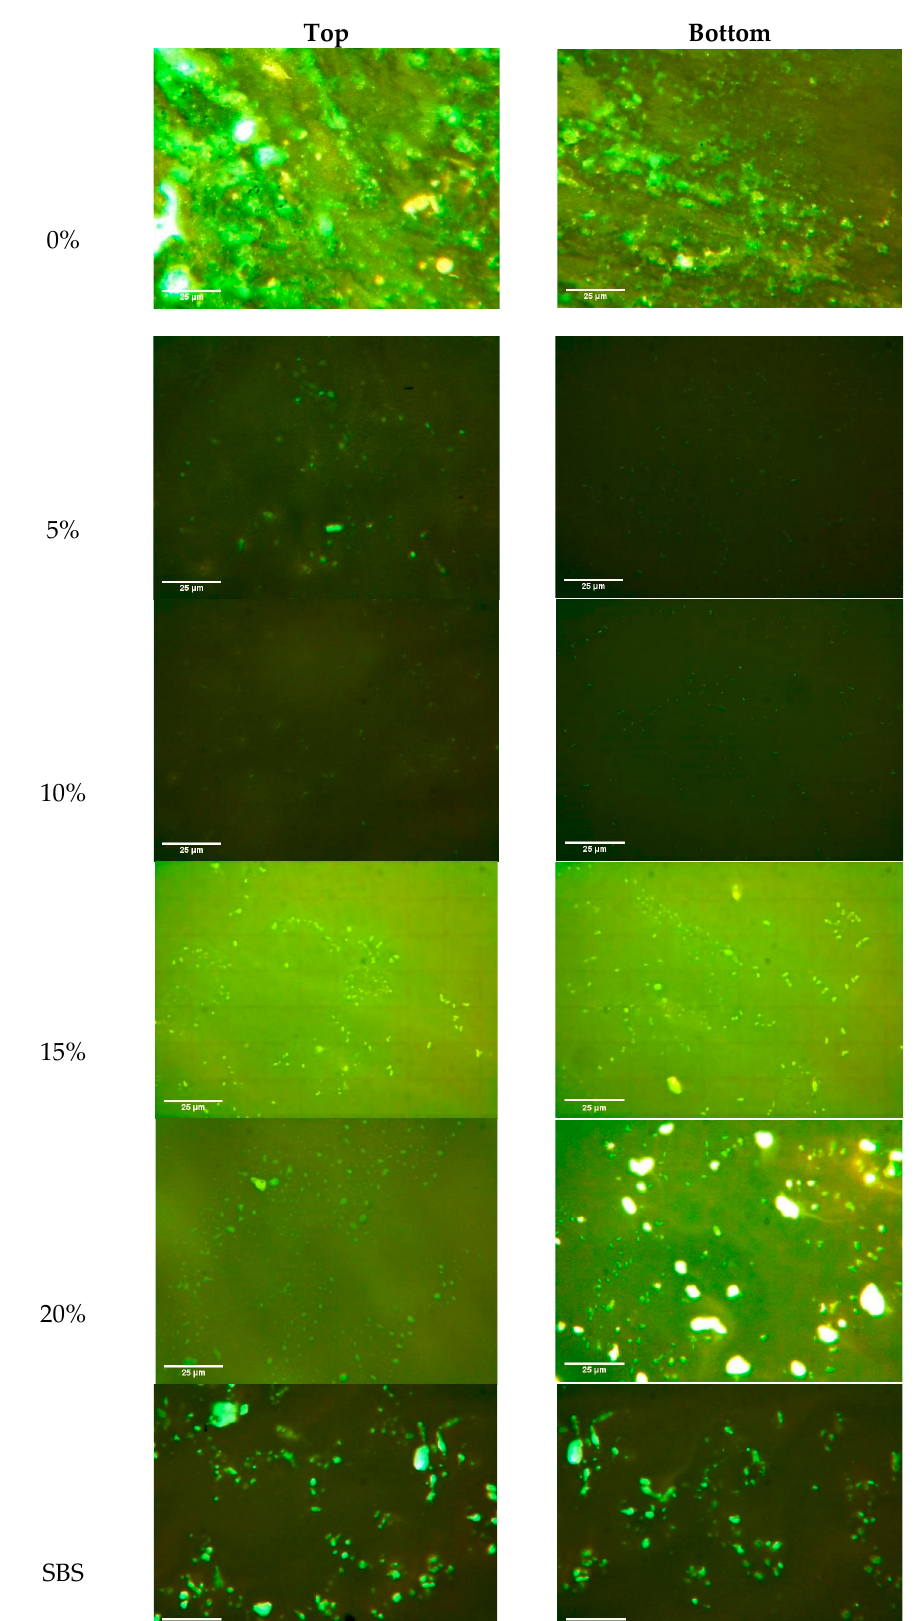
Figure 11. Fluorescence images of different asphalts after the segregation test.